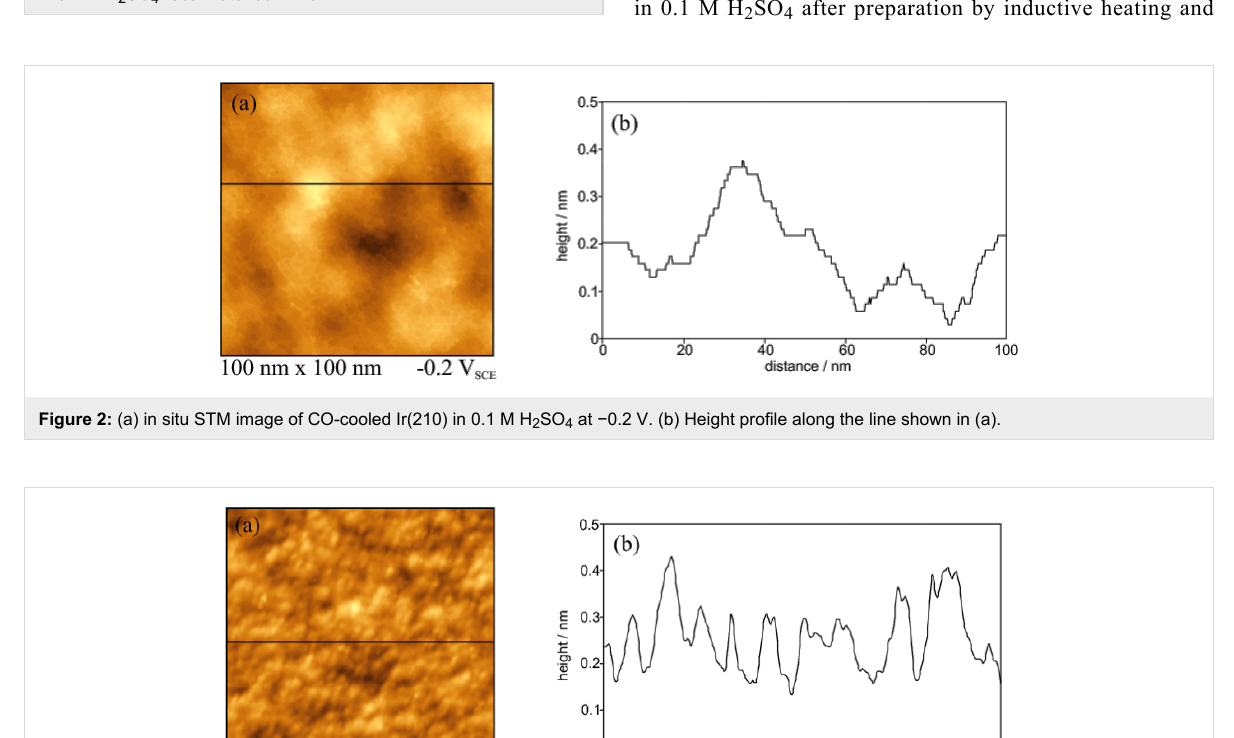
Figure 1: Cyclic voltammograms of Ir(210), which was annealed and cooled in a N 2 + CO mixture, after anodic stripping of the CO adlayer in 0.1 M H 2 SO 4 . Scan rate: 50 mV·s − 1